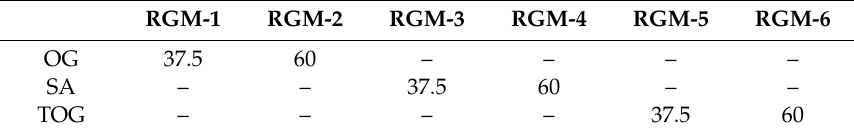
Table 1. Formulation of Repaglinide mucoadhesive tablets